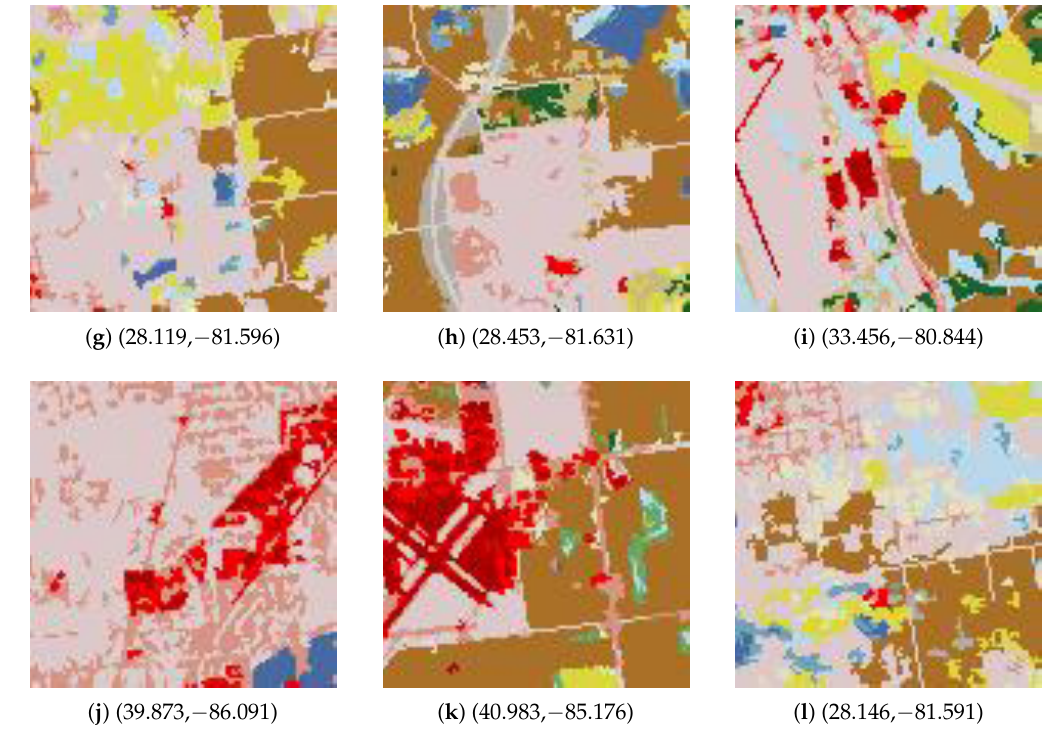
Figure 22. Top 12 scenes most similar to the reference scene (see Figure 21a) obtained by the approach proposed in [28]. The content in the brackets is the geographic coordinates of the scenes.